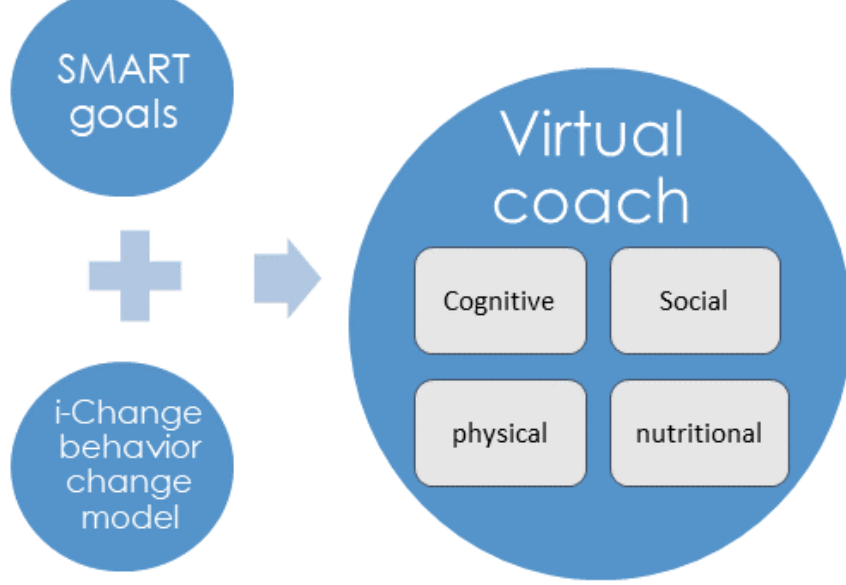
Figure 1. I-Change and SMART